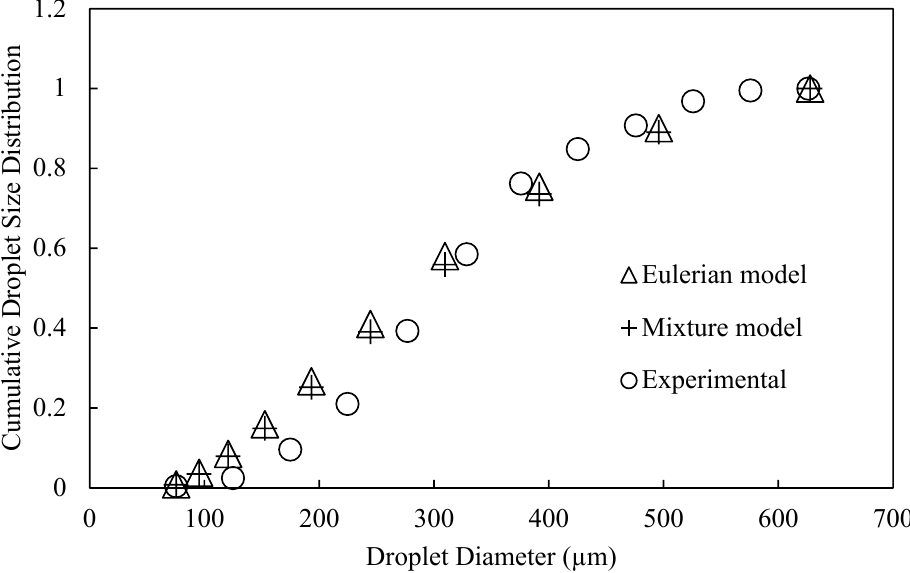
Figure 3. Comparison of cumulative droplet size distribution for computational fluid dynamics (CFD) results with experimental data using Eulerian and Mixture multiphase model.